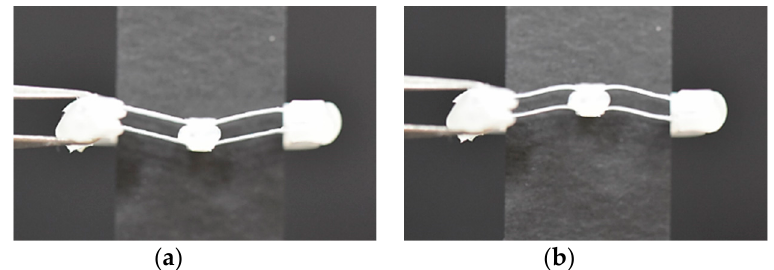
Figure 15. Photograph of the structure (front main frame segment is cut off and a black paper strip